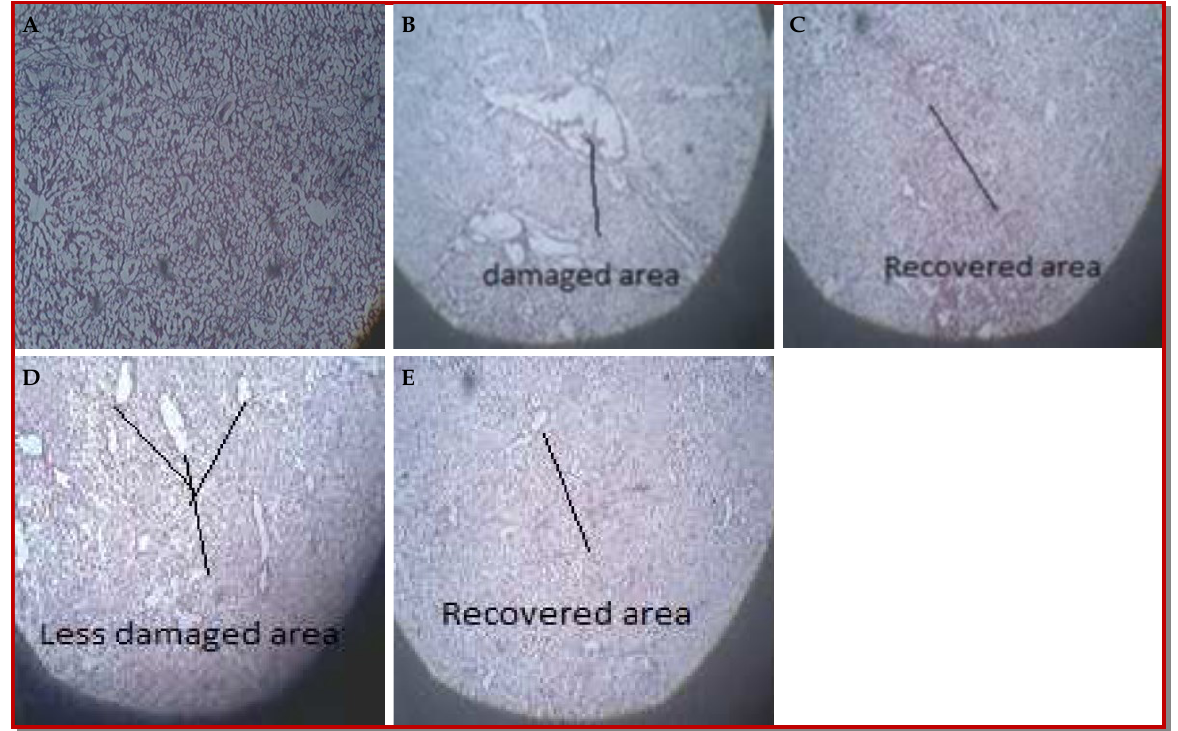
Figure 1: Histopathological slides of liver of different animal groups. (A) Normal control; (B) Carbon tetrachloride negative con- trol; (C) Standard control; (D) Test group 1; (E) Test group